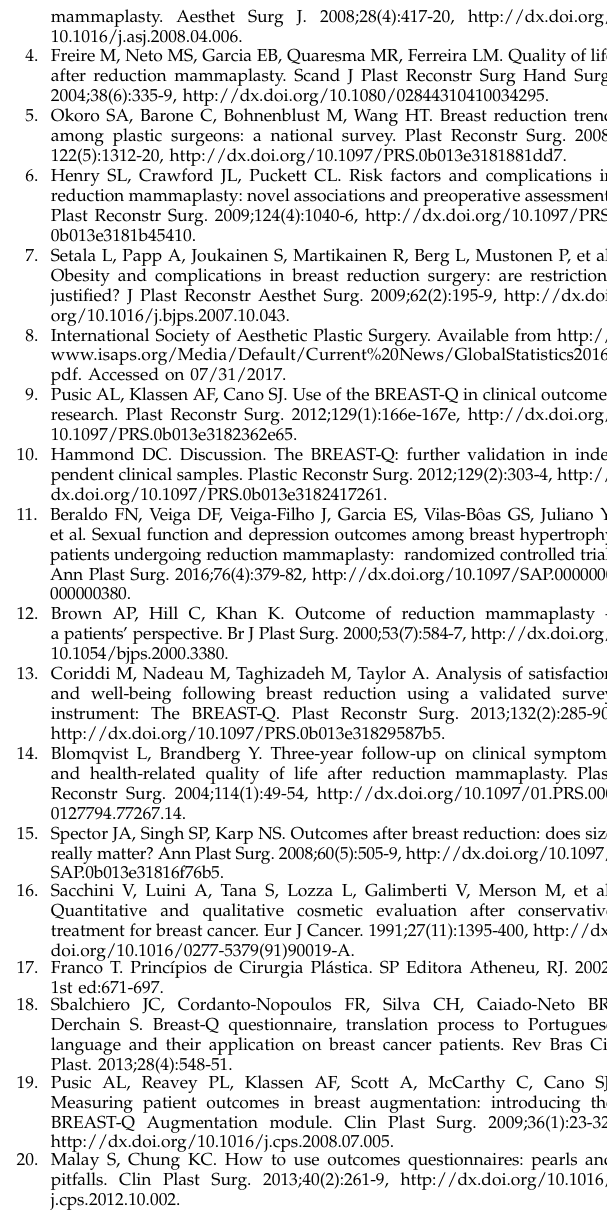
Figure 9 - Scores of BREAST-Q s subscales applied to the MG